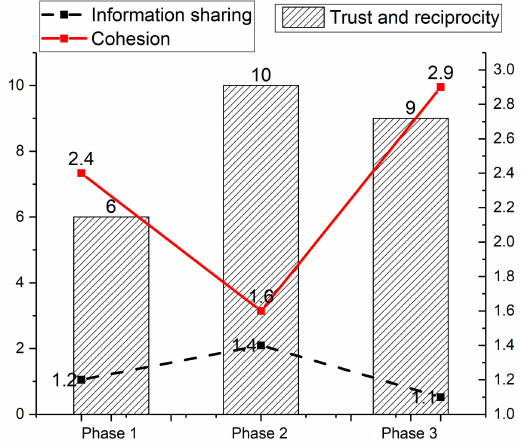
Figure 2. Bonding social capital during different phases of the